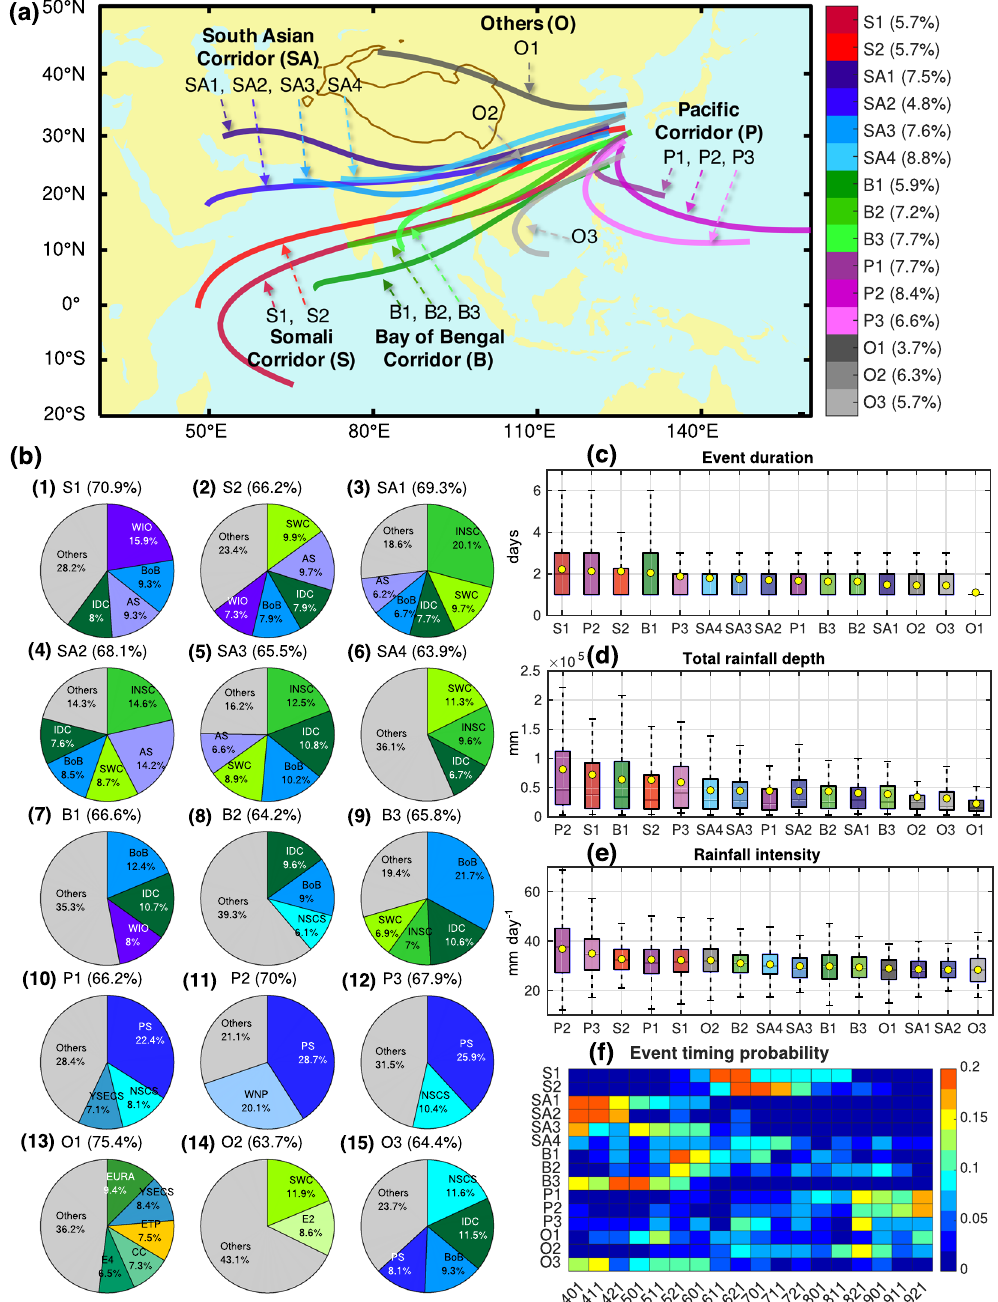
Fig. 1 Spatiotemporal features and moisture sources for the 15 moisture channels. a The regression curves derived from the backward moisture trajectories of the East Asian rain belt events from April through September in 1981 – 2018. Most moisture channels are labeled according to the corresponding corridors, including Somali corridor (S), South Asian corridor (SA), Bay of Bengal corridor (B), and Paci fi c corridor (P). Other types of channels are labeled with an O. Numbers in the parentheses aside the color bar show the percentages of trajectories (~1 million) assigned to individual clusters. b Pie charts of different sources ’ contributions to rain belt events assigned to each moisture channel. Sources with contributions greater or equal to 6% are labeled with the acronyms, while the rest are grouped into the category “ Others ” . The de fi nition of acronyms can be found in the caption of Supplementary Fig. 1. The total attributed fractions of precipitation are shown in the subtitles. c Box plots of duration (unit: day), d total rainfall depth (unit: mm) and e rainfall intensity (unit: mm day − 1 ) of rain belt events in each cluster. The boxplots are the traditional ones with the bars representing the maximum, 75th quantile, median, 25th quantile, and minimum. All boxplots are sorted in descending order of the mean (denoted by a yellow dot). f Heatmap of the arrival timings of rain belt events in each cluster in terms of probability. The number “ 401 ” in the x -axis denotes a dekad (i.e., 10 days) from April 1 to 10, and a similar convention applies to other